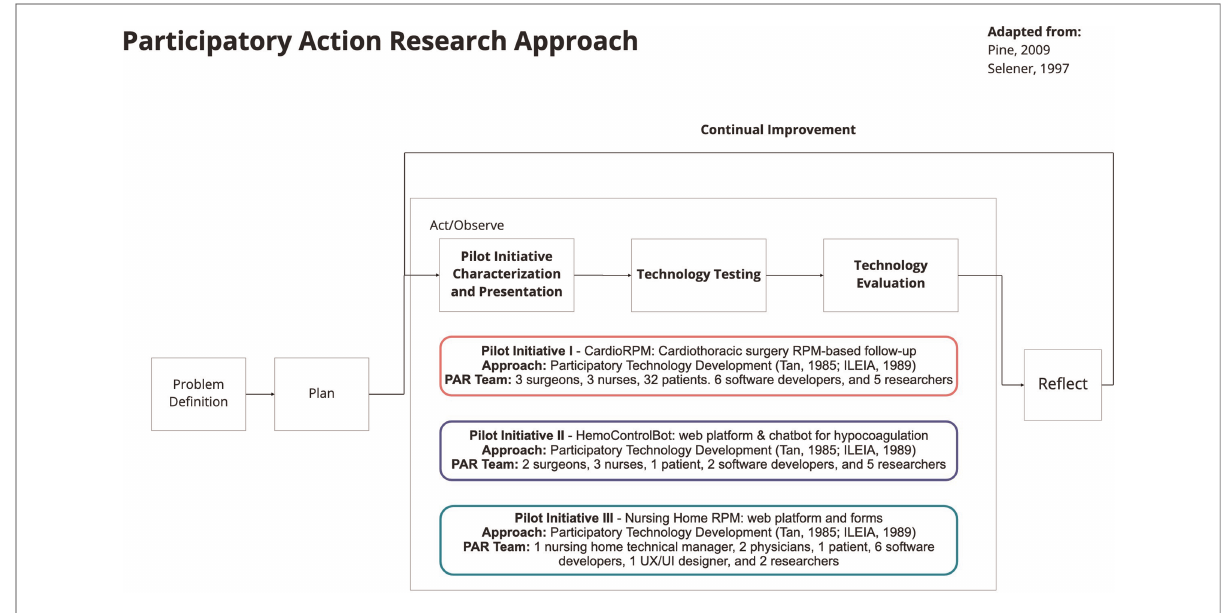
FIGURE 1 Participatory research process adapted from Selener (15) and Pine